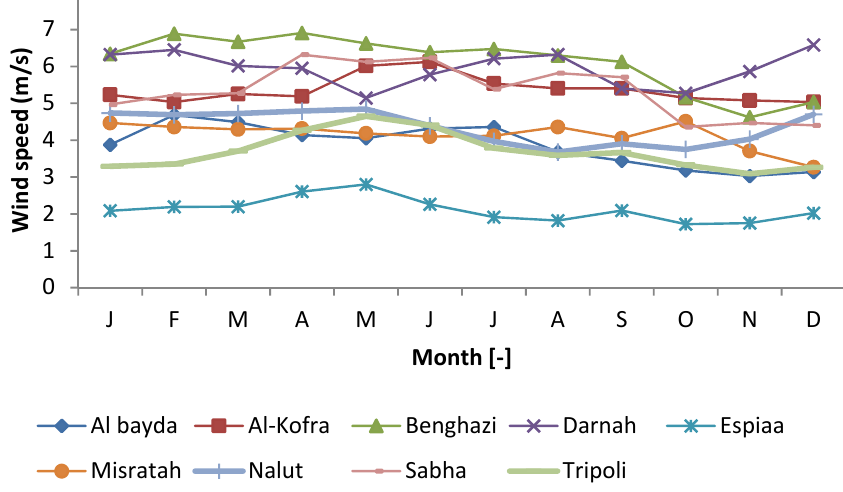
Figure 3. Actual mean monthly wind speed for all selected regions in Libya.